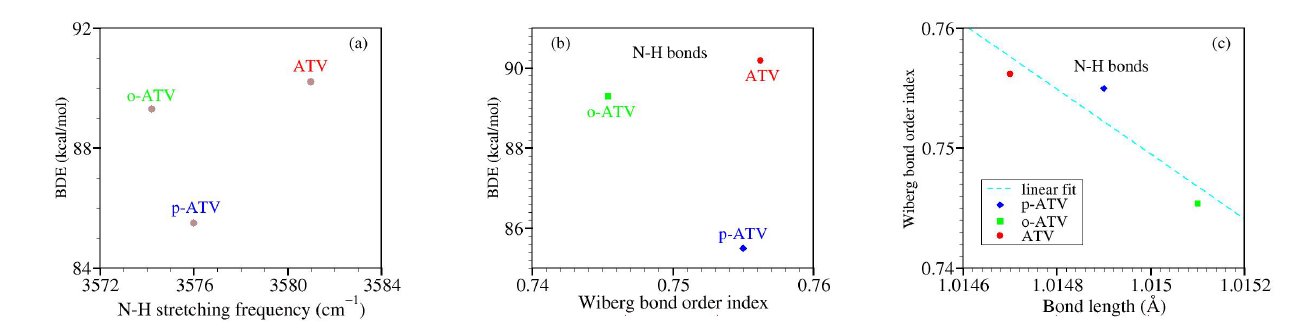
Figure 10. Results similar to Figure 9 but for NH groups: ( a ) bond dissociation energies versus N-H stretching frequencies; ( b ) bond dissociation energies versus Wiberg bond order indices; ( c ) Wiberg bond order indices versus bond lengths.